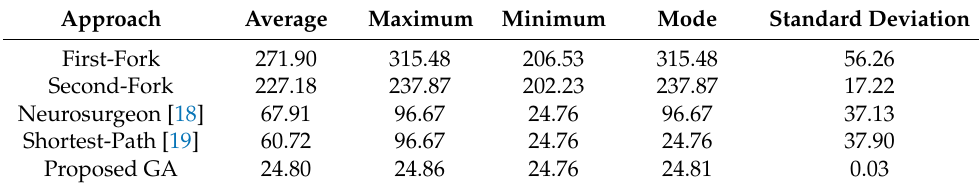
Table 3. Comparison of B-AlexNet total execution time (ms) found by different approaches.